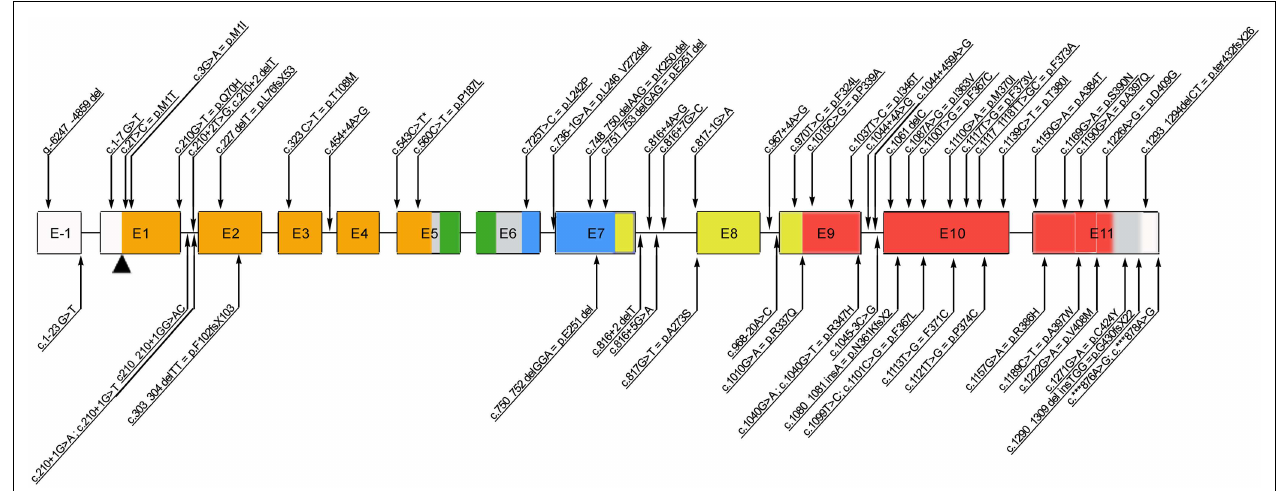
CCDS14323.1). *c543C > T is a polymorphism. E, exon; Color code: orange, N-terminal domain; green, zinc finger domain; blue, leucin-zipper domain; red, forkhead